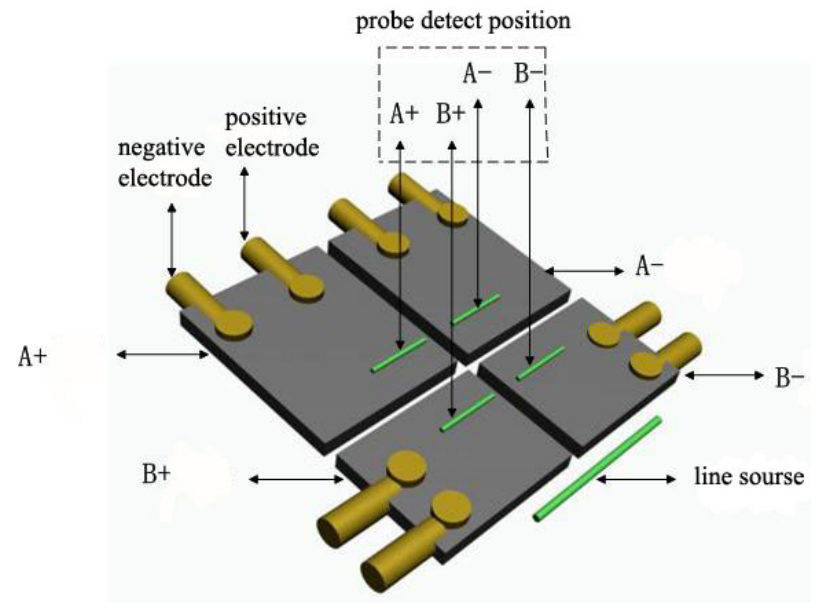
Figure 3. Four-quadrant PVDF foil piezoelectric SAW